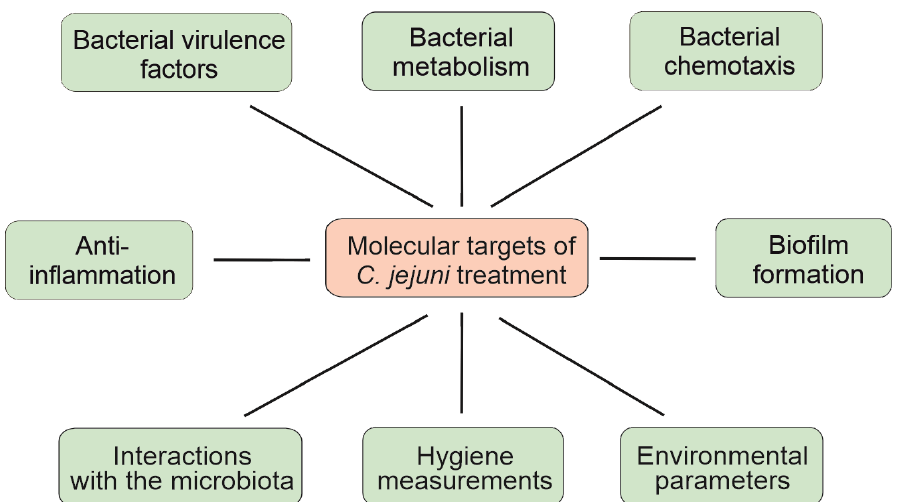
Figure 1. Overview of the molecular targets in C. jejuni treatment strategies. For more details, see text.